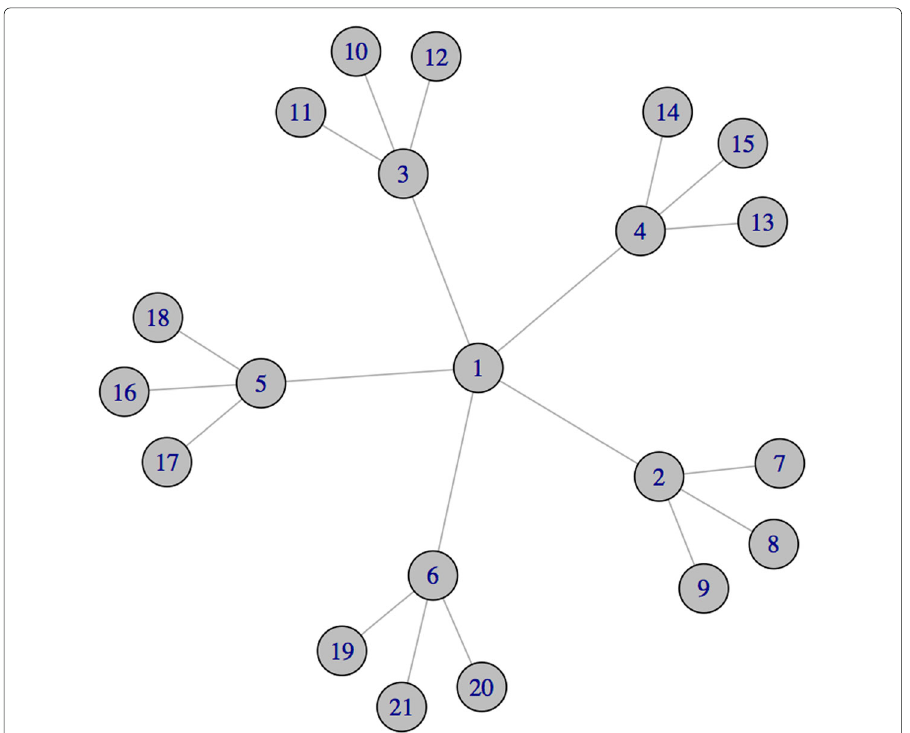
Fig. 1 A network with 21